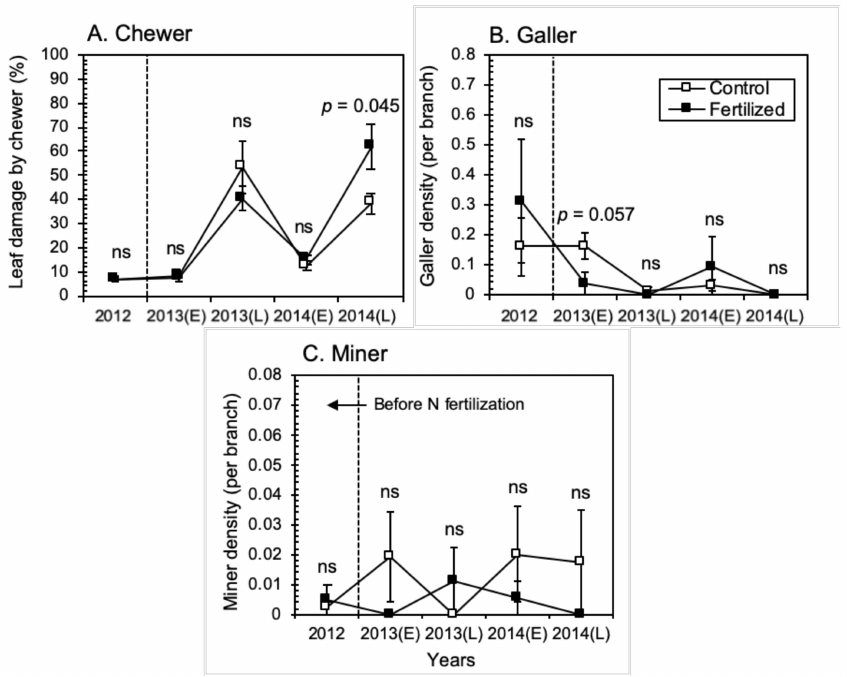
Figure 2. Changes in the three major guilds of insect herbivores categorized based on feeding type. ( A ) Leaf damage by chewers, ( B ) galler density, and ( C ) miner density on trees in control (empty boxes, n = 5) and fertilized (filed boxes, n = 5) sites from 2012 (before N fertilization) to 2014. E and L indicate early and late seasons. Each point is mean ± SE and the p -values are the results of t -tests (ns, p >